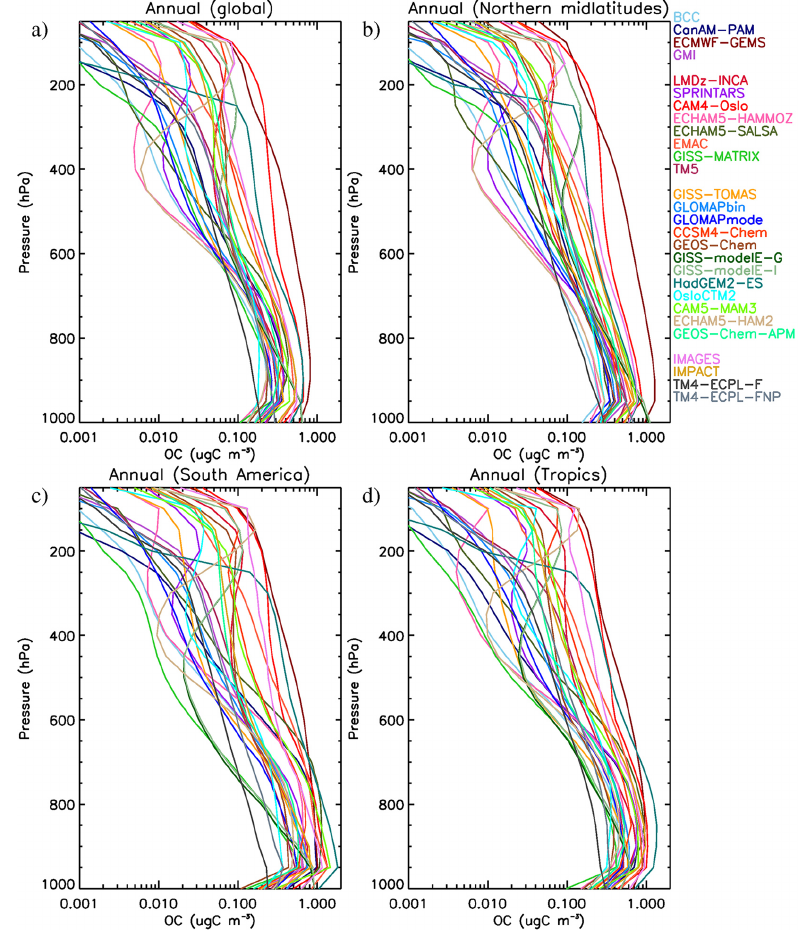
Figure 8. Annual mean vertical profiles of OC (at ambient conditions) interpolated at 50hPa steps from the surface to 50hPa for OC: (a) Global, (b) northern mid-latitudes, (c) South America and (d)